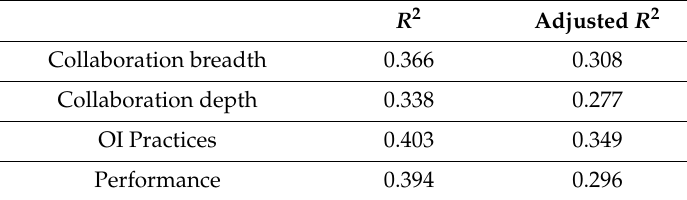
Table 19. Coe ffi cient of determination ( R 2 values) with quadratic e ff